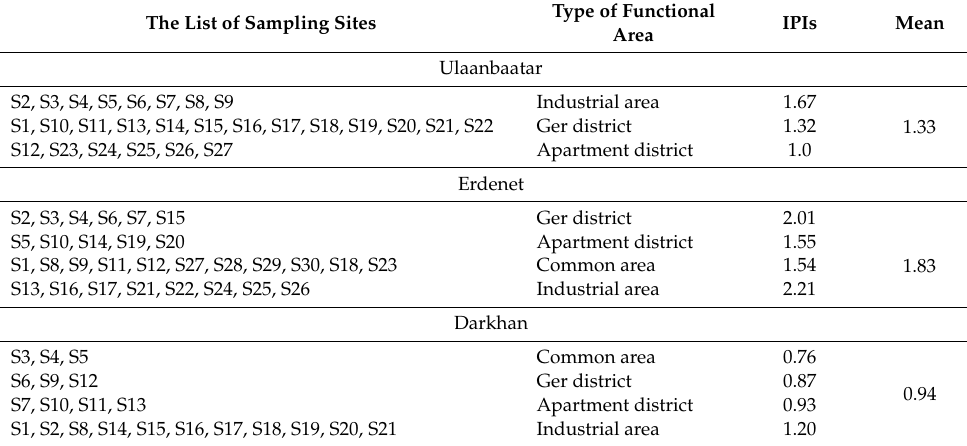
Table 6. Integrated pollution index (IPI) in di ff erent functional areas and each city (Ulaanbaatar, Erdenet, and Darkhan). Erdenet, and